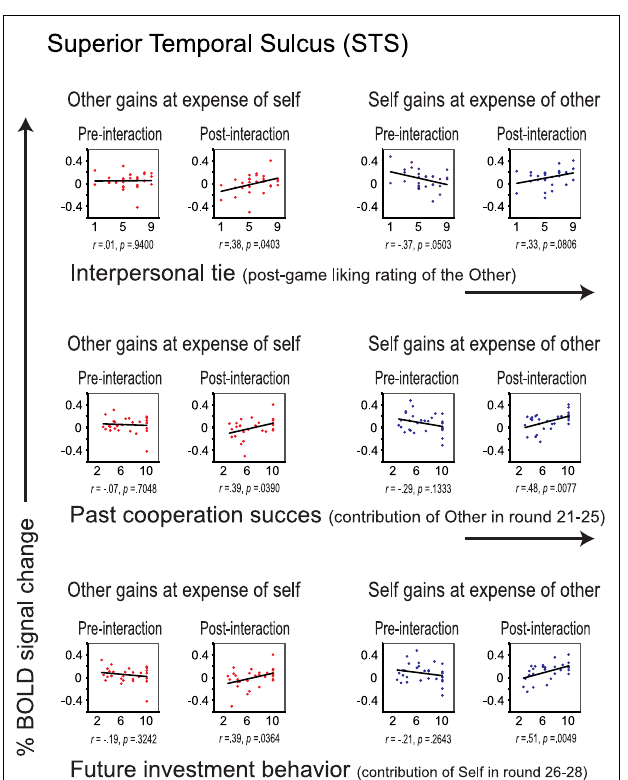
FIGURE 6 | Correlations between liking (top), past cooperation success (middle) and future investment behavior (bottom), and percent signal change in the pSTS, separately for the pre- and post-interaction DOT. Correlations are shown for sharing in which the other gains at the expense of self (in red), and for sharing in which oneself gains at the expense of the other (in blue), separately for the DOT prior to interaction (pre-interaction, first and third column) and for the second DOT (post-interaction, second and forth